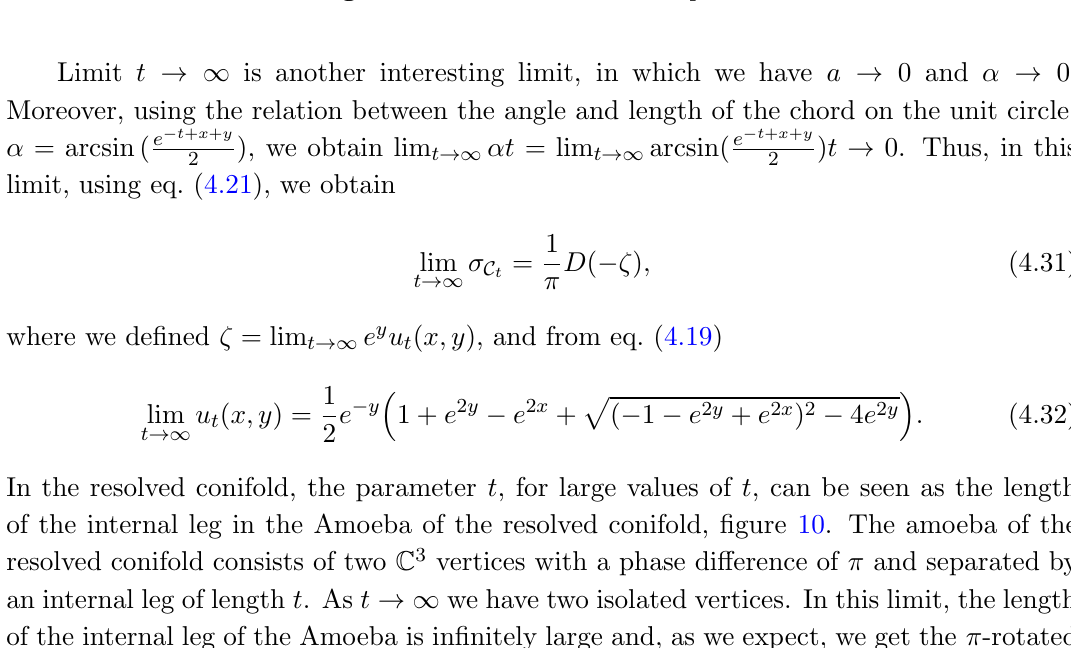
Figure 7 . Pro(cid:12)le of the conifold